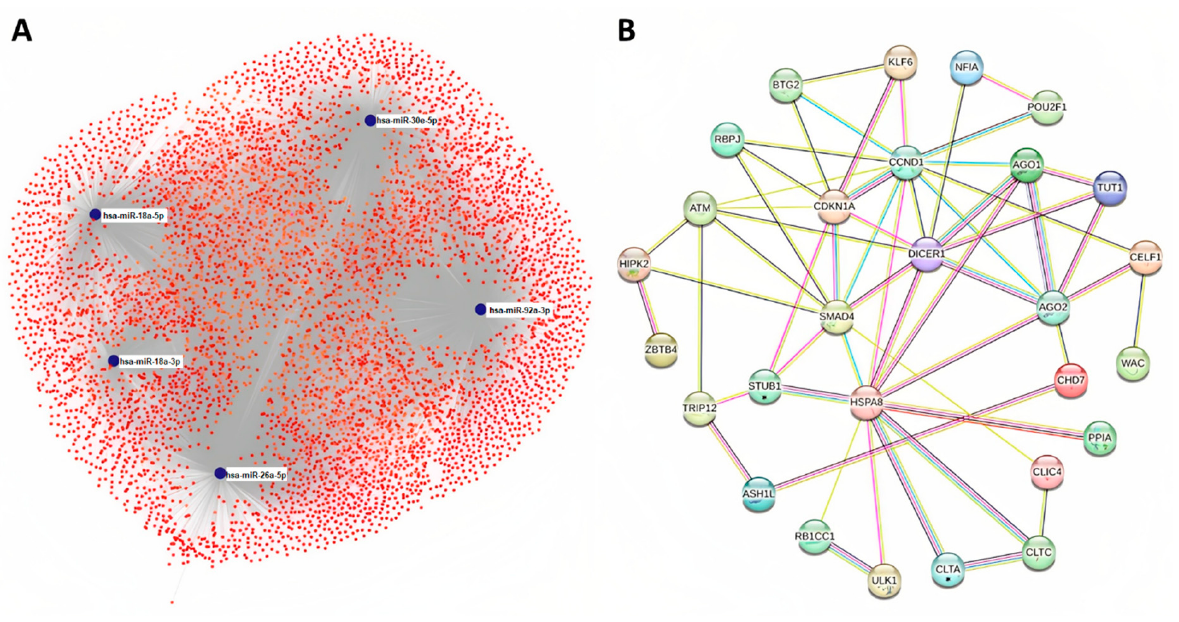
Figure 3. Target prediction and protein association network analysis. ( A ) In total, six thousand and thirty-seven different genes were predicted as potential targets of five significantly deregulated miRNAs (miR-18a-3p, miR-18a-5p, miR-26a-5p, miR-30e-5p and miR-92a) using miRNet online tool. ( B ) Protein–protein interaction network of twenty-six hub genes regulated by identified miRNAs (STRING) together with two other genes (with asterisk) significantly involved in the network. Light blue line—from curated databases, pink line—experimentally determined, yellow line—textmining, black line– co-expression, light purple line—protein homology, red line—gene fusions, dark blue line—gene co-occurrence.